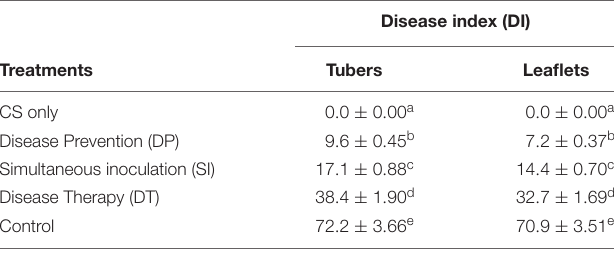
TABLE 1 | Biocontrol effect of B. megaterium WL-3 on potato tissues in